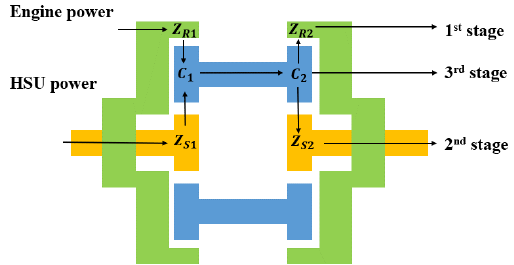
Figure 3. Schematic diagram for the compound planetary gear of the HMT.